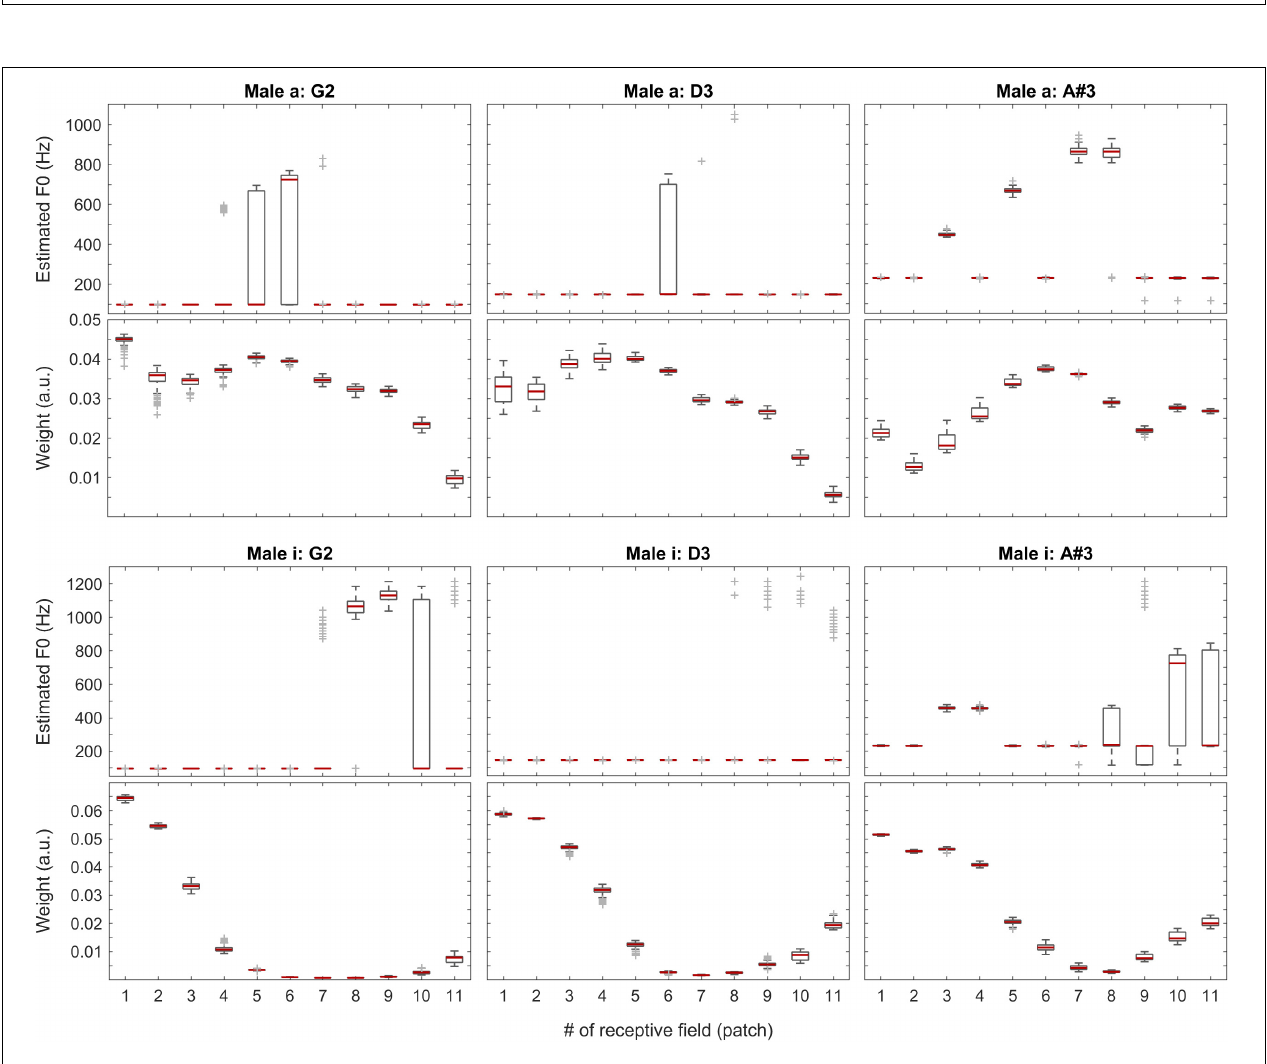
FIGURE 7 | Median of the weights (over all 100 iterations) for the complete tested pitch range for the sung vowel recordings. From left to right: a: and i: by female singer, then a: and i: by male singer.